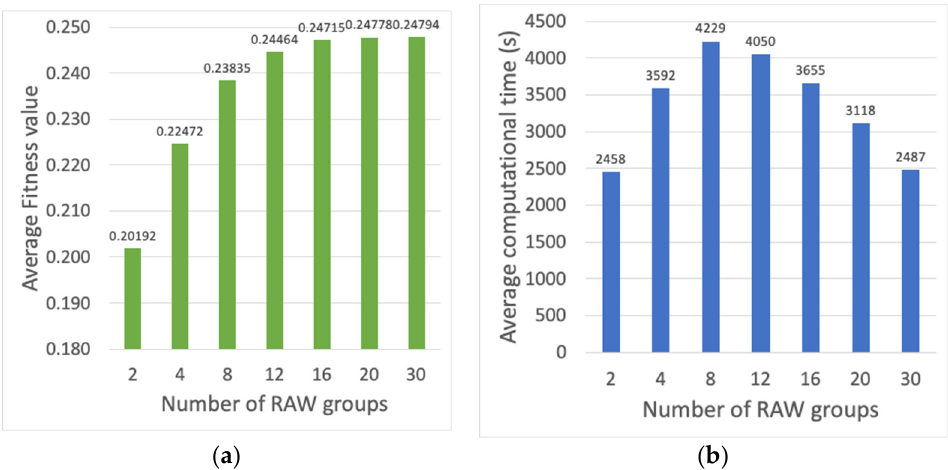
Figure 8. ( a ) Average fitness value of the best individual, ( b ) average computational time (s), vs. number of RAW groups comprised between 2 and 30.